Question: Does the plotted quantity increase or decrease?
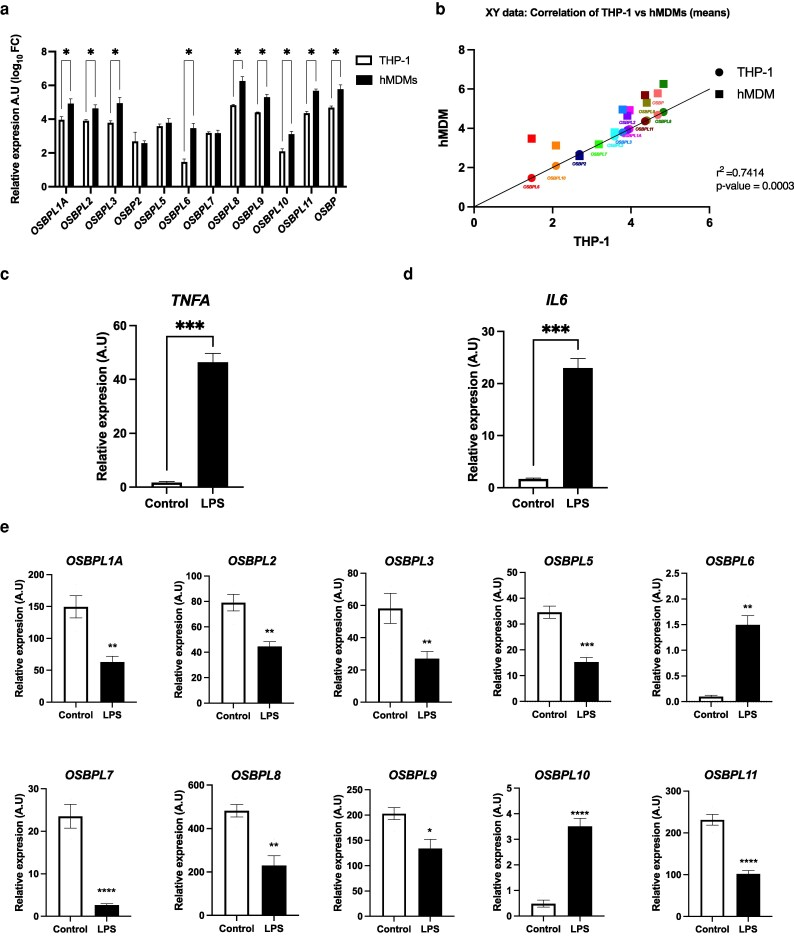
Answer: increasing